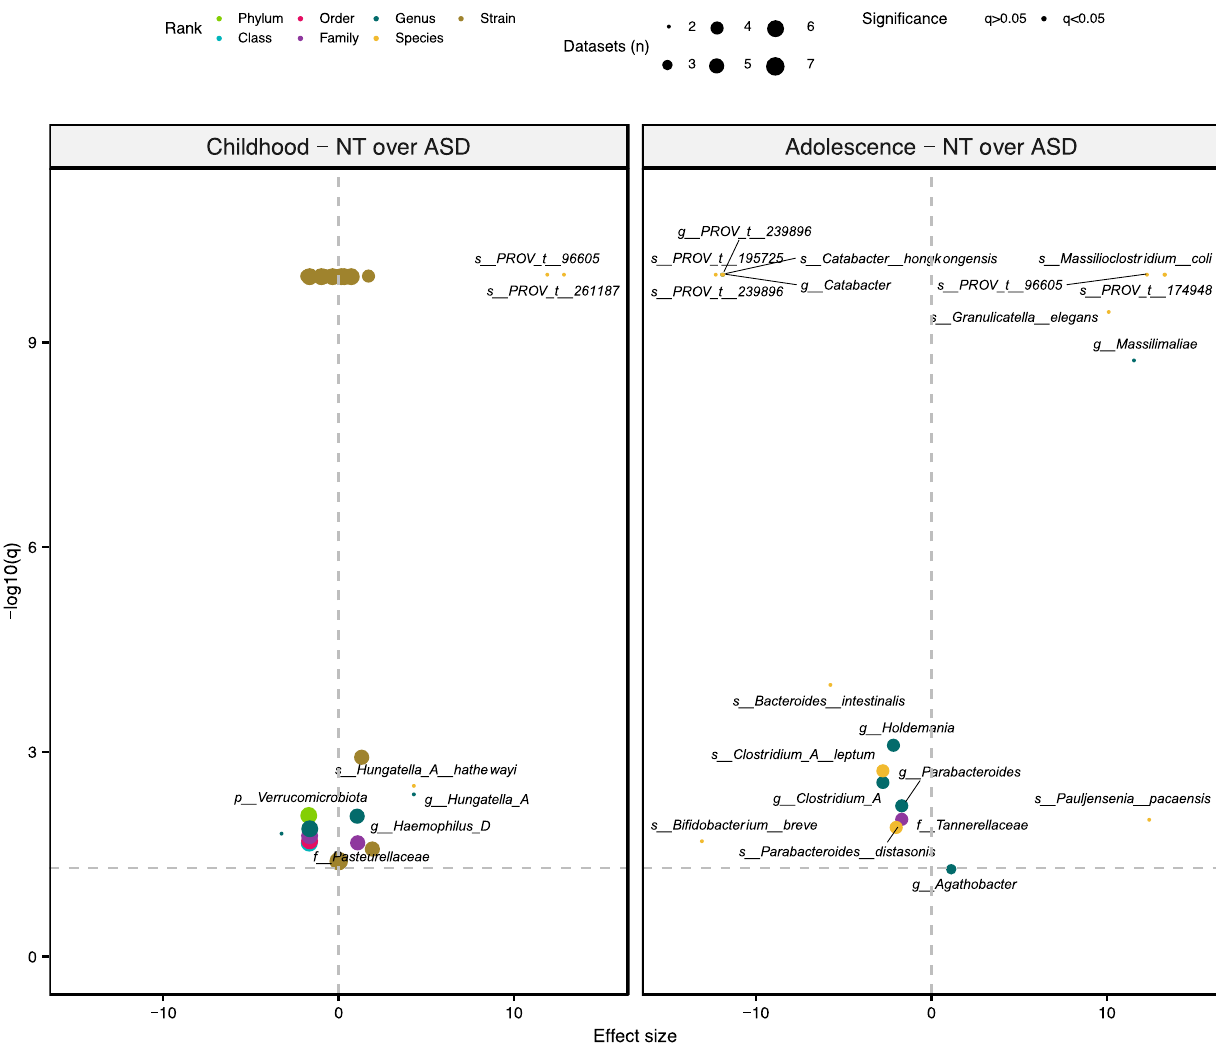
Figure 5. ASD-associated taxa abundance depends on the period of life studied. Effect sizes and q -values from random-effects models investigating the associations between different taxa and NT (positive direction) or ASD (negative direction) at different stages of childhood are plotted. The color, transparency, and size of each point denotes the taxonomic rank of the taxon, the significance of the model, and the number of datasets included in the model, respectively. Horizontal dotted line indicates significance threshold (q = 0.05). Significant models are labelled by the taxon investigated except for strain-level results. These models are reported in Supplementary file 1: Table